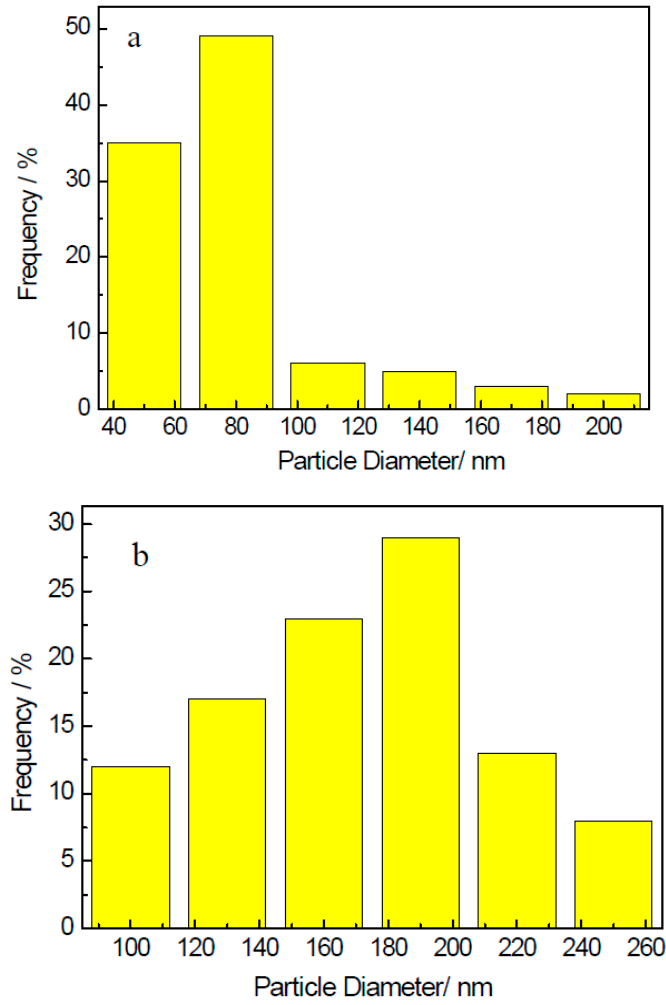
Figure 8. Nb particle size histograms obtained from SEM images showing the Nb particles larger than 50 nm. ( a ) annealed at 700 °C for 1 h; ( b ) annealed at 900 °C for 1 h. Table 1. Summary of Nb particle sizes after annealing under different conditions. (Note: Ф Nb,SEM is the average Nb particle size observed by SEM, and Ф Nb,TEM is the average Nb particle size measured by TEM).